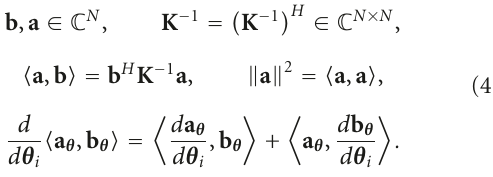
Figure 1: The image represents a gray scale encoding of tissue types and includes cancellous bone, bone marrow, blood, lungs, muscle, fat, skin, nerves, and so forth. In the model, all but the blood contained in the aorta contribute to an average material ( γ ) based on surface areas. The two circles around the aorta represent the aorta at two di ff erent instants; r , R refers to the first of these, while r + Δ r , R − Δ r would refer to the